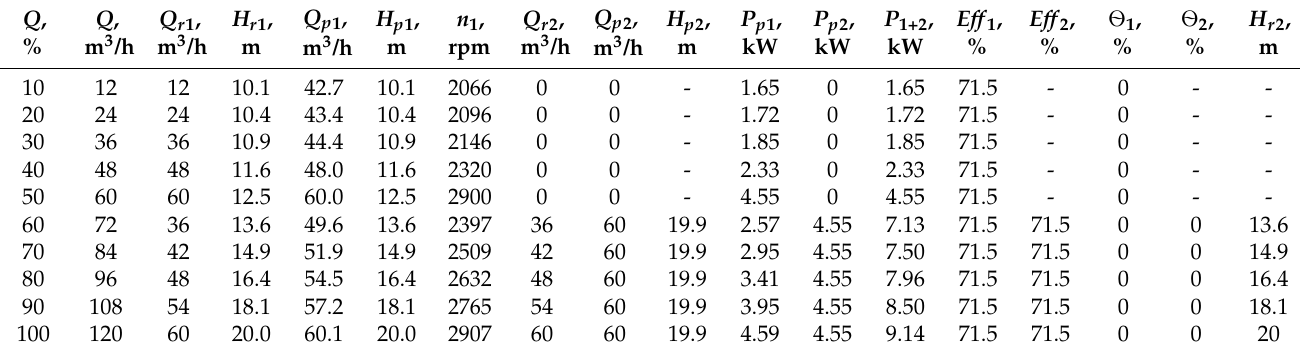
Table 3. Pump system performances applying the maximum reliability control.